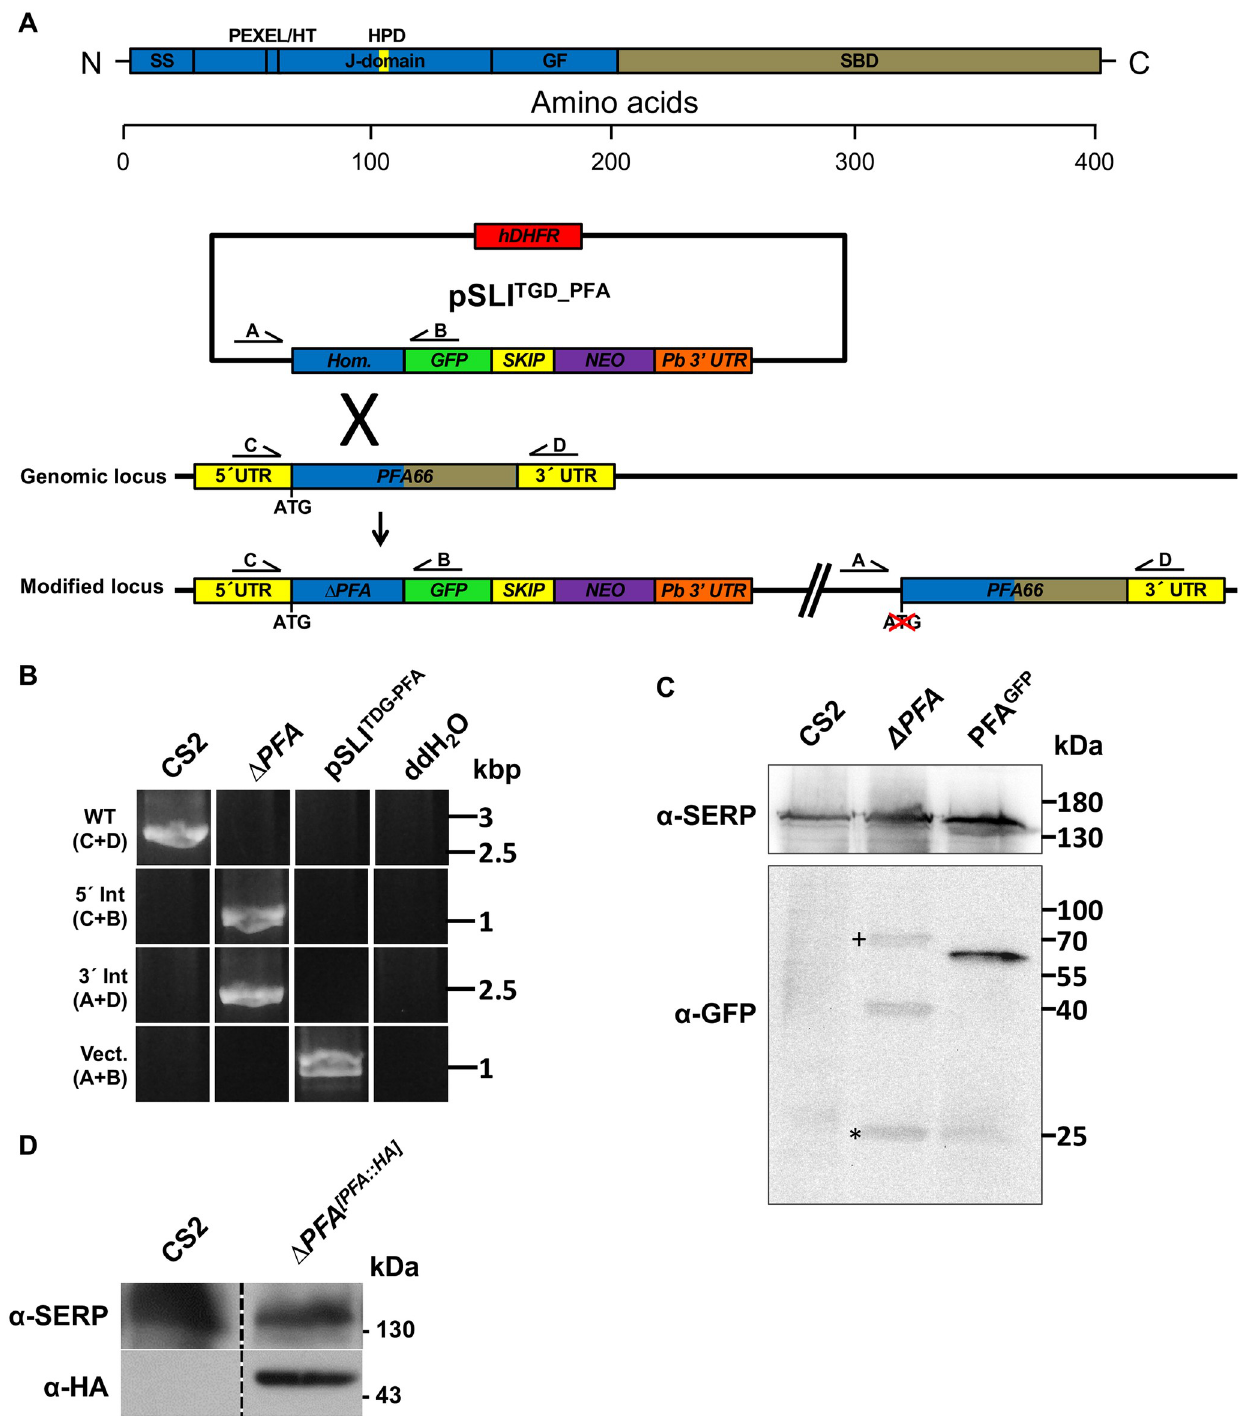
Fig 1. Generation and verification of the Δ PFA cell line. A) Strategy for inactivation of PFA0660w via selection-linked integration. Expression of a neomycin resistance marker (NEO) is coupled to integration of the plasmid pSLI TGD_PFA into the genomic PFA0660w locus, leading to expression of a truncated (likely inactive) PFA66 missing its substrate binding domain (SBD). Production of PFA and NEO as separate proteins is mediated with a SKIP peptide. B) Integration PCR using gDNA extracts from the cell line Δ PFA and the parental cell line CS2 verifies integration of the plasmid pSLI TGD_PFA into the PFA0660w gene in the cell line Δ PFA . Amplification of the wild type PFA0660w locus with the primers C and D is only successful in the parental strain CS2 since integration of the plasmid dramatically increases product size. PCRs using primers spanning the junctions of the integration sites C and B for the